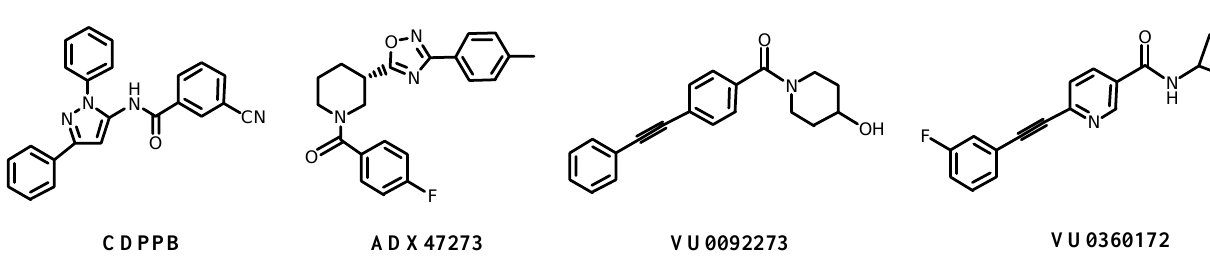
Figure 1. Structure of systemically active mGluR5